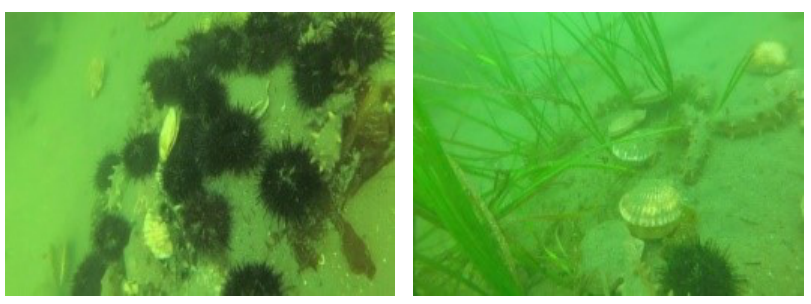
( a ) Figure 10a sigma1 optimization curve ( b ) Figure 10b sigma1 optimization curve